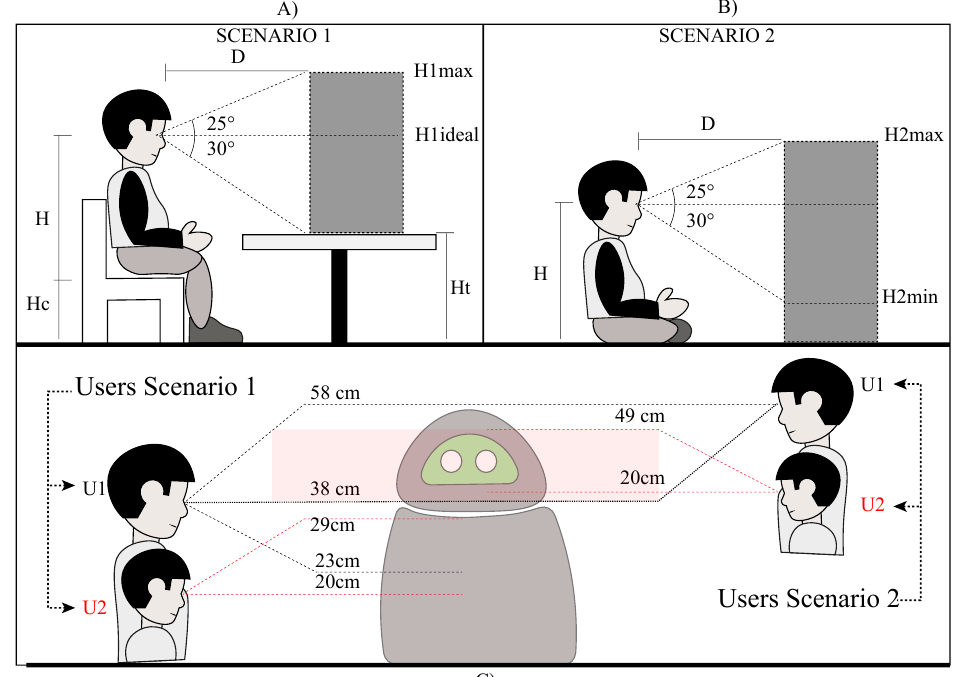
Figure 3. Experimental setup for the ergonomic analysis. ( A ) illustrates the sitting condition in a chair. ( B ) shows the sitting condition on the floor. ( C ) is comprised of the children’s range of vision for both scenarios, the line of sight of the robot, and the optimal height range of the robot. The variable U refers to the user involved in this analysis (U1: 10-year-old and U2: 5-year-old); H denotes the distance between the sacrum and the user’ line of sight; H c represents the chair height; H t symbolizes the table height; H 1 − 2; max − min indicates the maximum values in the visual range; H n ; ideal constitutes the child’s line of sight; and D illustrates the distance between the child and the robot. The numerical values of these variables are given in Table